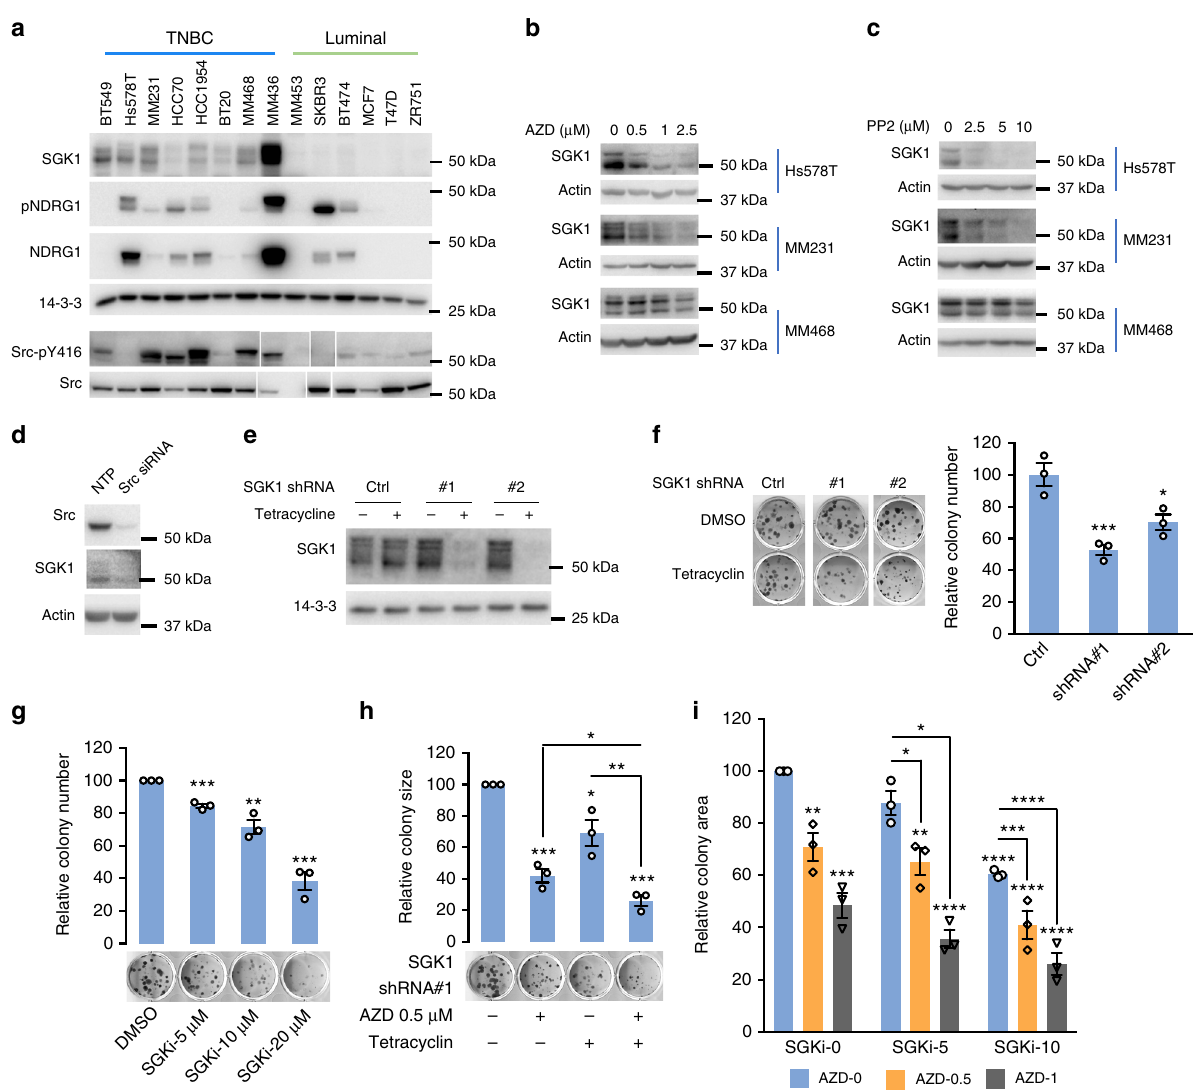
Fig. 7 SGK1 signals downstream of active Src in TNBC. a SGK1 expression and activity in breast cancer cell lines. Cell lysates were western blotted as indicated. The blots for Src and Src-pY416 were run in a different order but have been re-assembled to match the others, for ease of comparison. ‘ MM ’ indicates MDA-MB-. b , c Src inhibition decreases SGK1 expression levels in TNBC cell lines. Lysates were prepared from cells treated overnight with AZD0530 (AZD) ( b ) or PP2 ( c ). DMSO was the vehicle control. Representative blots are shown from n = 2 biological replicates. d Src knockdown reduces SGK1 expression levels in TNBC. Cell lysates from Hs578T cells transfected with a Src siRNA SMARTpool or non-targeting control (NTP) (20 nM) for 72 h were western blotted as indicated. Representative blots are shown from n = 2 biological replicates. e SGK1 knockdown by tetracycline-inducible